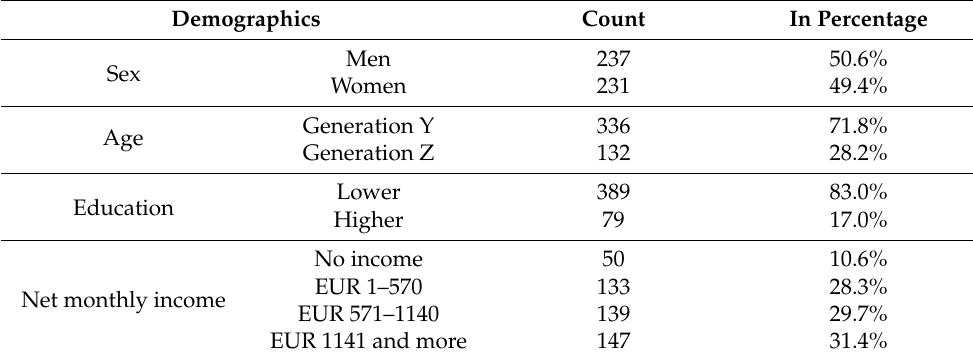
Table 1. Composition of